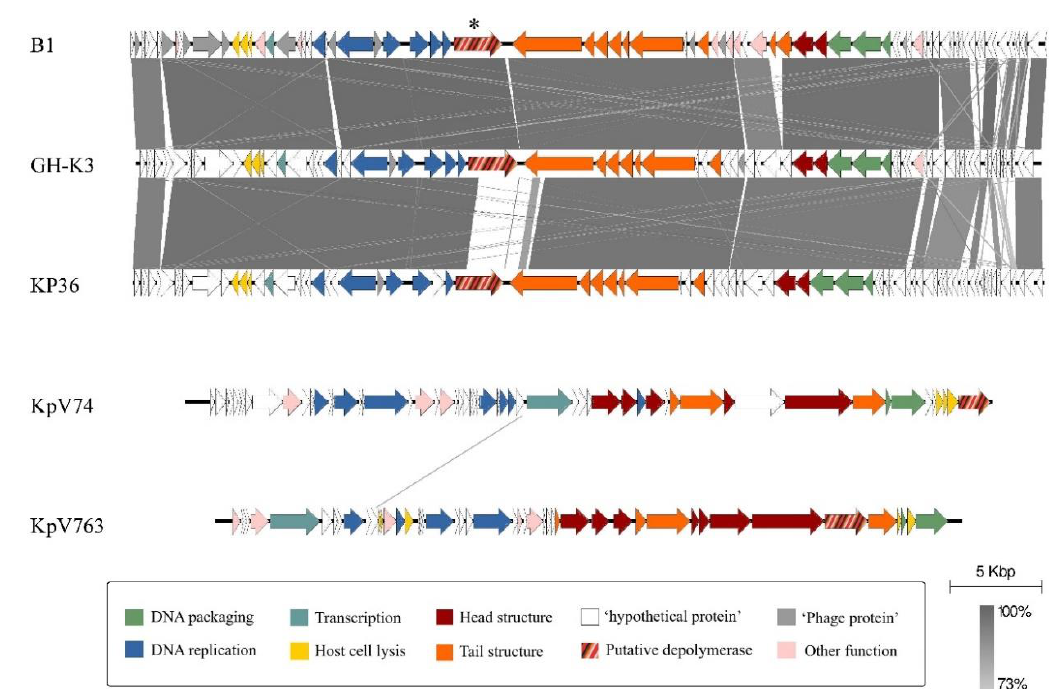
Figure 5. Representation of the homology similarities and differences of K. pneumoniae K2 serotype-specific phages and one reference phage of the Webervirus genus. Phage B1 (K2 specific, Siphoviridae ), GH-K3 (K2 specific, Siphoviridae ), KP36 (K63 specific, Siphoviridae , reference phage of the Webervirus genus), KpV74 (K2 specific, Podoviridae ), and KpV763 (K2 specific, Podoviridae ). Orf61 of phage B1 is marked with an asterisk ( * ). Homology was only restricted to the N-terminal between the depolymerase genes of B1 and KP36, as well as between GH-K3 and KP36, while no homology could be revealed to the two K2 specific podophage sequences. Annotations of the genomes were performed by the RAST server and were visualized by Easyfig. Table 2. Comparison of Klebsiella phages with K2 depolymerase activity. The phage genome similarities are presented in Figure 5. The old and recent classification of the phages are indicated, according to the International Committee on Taxonomy of Viruses (ICTV) website (https://talk.ictvonline.org/taxonomy/, access date: 19 March 2021), along with capsule specificity and recent research status of each depolymerase.